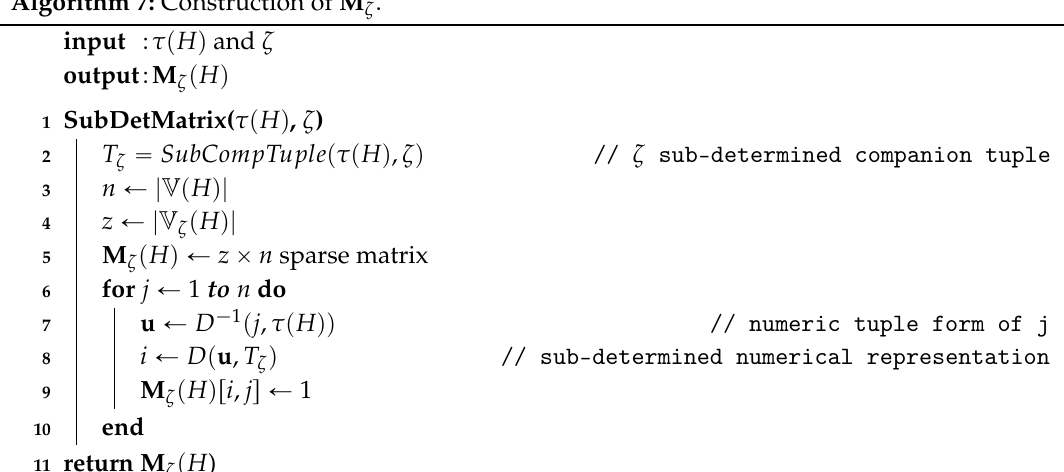
Algorithm 7: Construction of M ζ